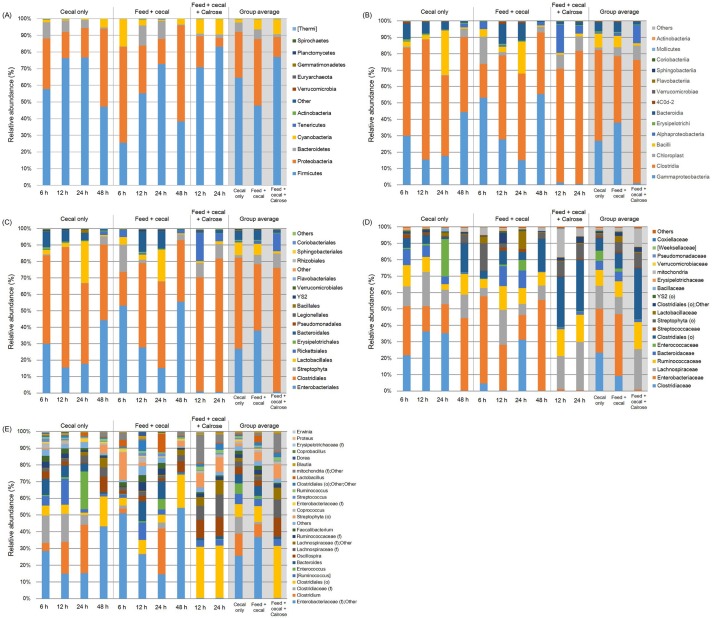
Relative abundance of major bacteria among different treatment groups at (A) phylum, (B) class, (C) order, (D) family, and (E) genus level in anaerobic mixed cultures (adapted condition) containing cecal contents.Microbiome analysis was conducted in triplicate on cecal contents only, feed and cecal contents, and feed + cecal + Calrose at various time points using cecal contents from 48 day-old broiler chickens. The bars represent the standard deviation. “f” and “o” in parentheses indicate family and order, respectively.